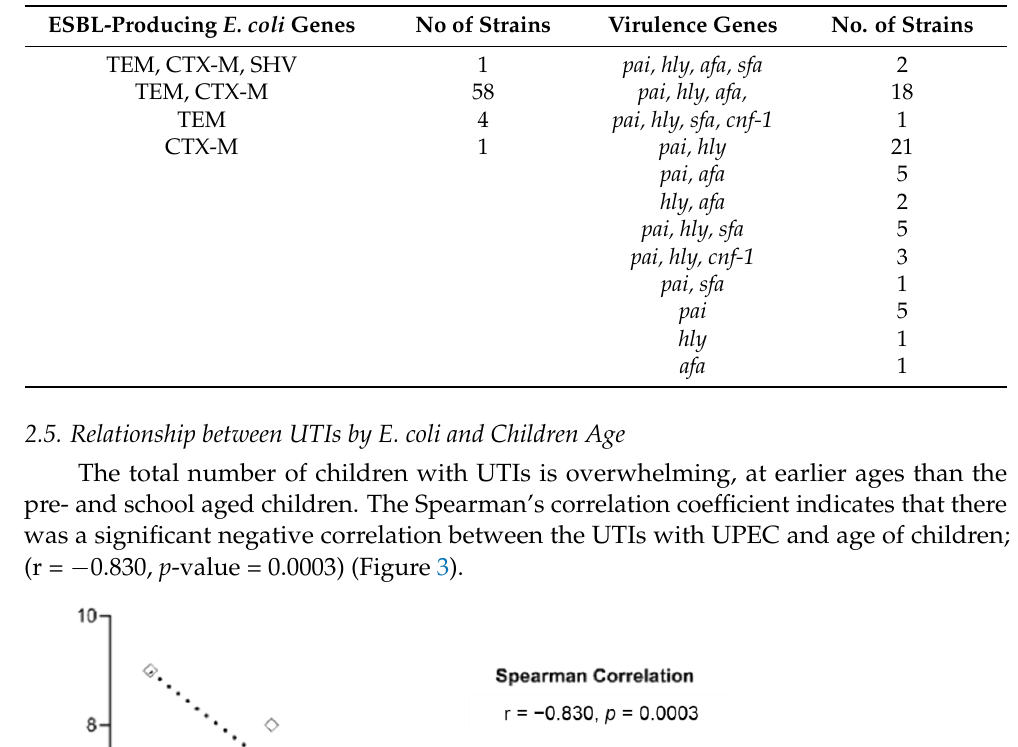
( b ) Figure 4. Correlation analysis between the children of all ages and antibiotic resistance to ( a ) and both the marker genes of ESBL-producing and virulence factors ( b ) of UPEC infection. This figure depicts the relationship between the antibiotic resistance to UPEC and the age of the children, where antibiotic resistance and gene markers for UPEC are illustrated in number terms. Each marker de- notes a specific observation for antibiotics resistance and the age (years) of a particular child. This figure depicts the relationship between the UTIs with UPEC and the age of children, where UTIs are illustrated in number terms. Spearman’s correlation was performed by GraphPad Prism and a significance was considered to be established when p > 0.05. Spearman’s correlation method was carried out by GraphPad Prism, and significance was considered to be established when p > 0.05. Keys: TE: Tetracycline, AK: Amikacin, CAZ: Ceftazidime, AX: Amoxicillin, CTX: Cefotaxime, F: Ni- trofurantoin, AM: Ampicillin, SXT: Trimethoprim/Sulphamethoxazole, AMC: Amoxicillin/Clavu- lanic acid, ATM: Aztreonam, CRO: Ceftriaxone, C: Chloramphenicol, CFM: Cefixime, NA: Nalidixic acid, and ESBL: ESBL-producing E. coli . Gene markers include pai : pathogenicity island, hly : hemo- lysin.